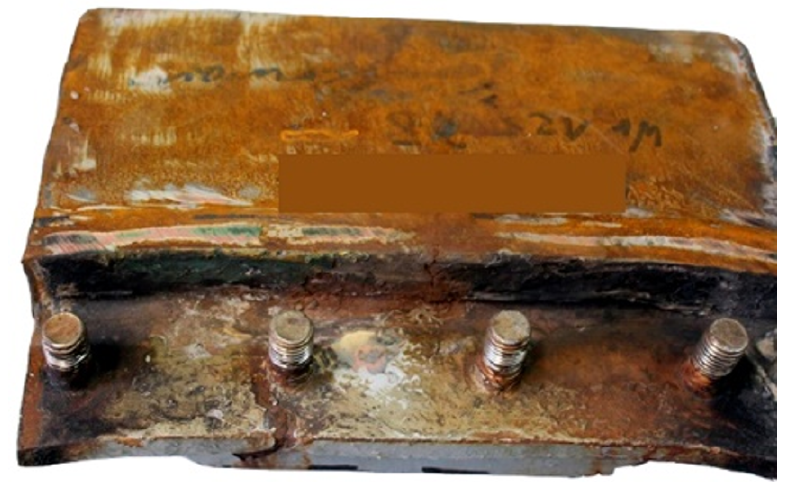
Figure 10. The section of a marine manhole from the handy-size bulk carrier 30206 DWT. Macro- scopic